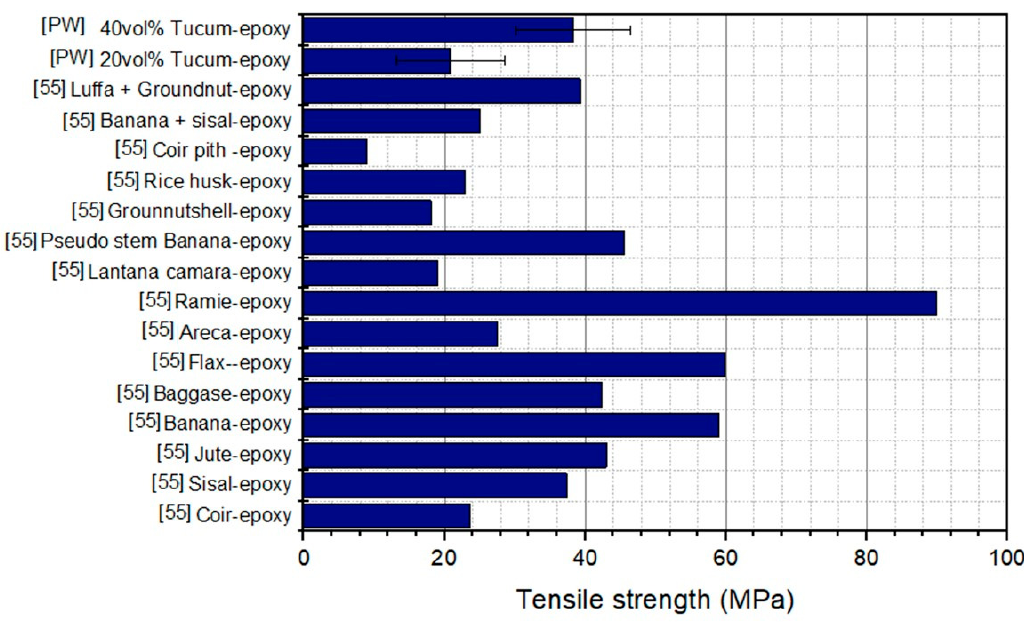
Figure 8. Tensile strength comparison between tucum fiber (Present work (PW)) and others natural fiber epoxy composites.